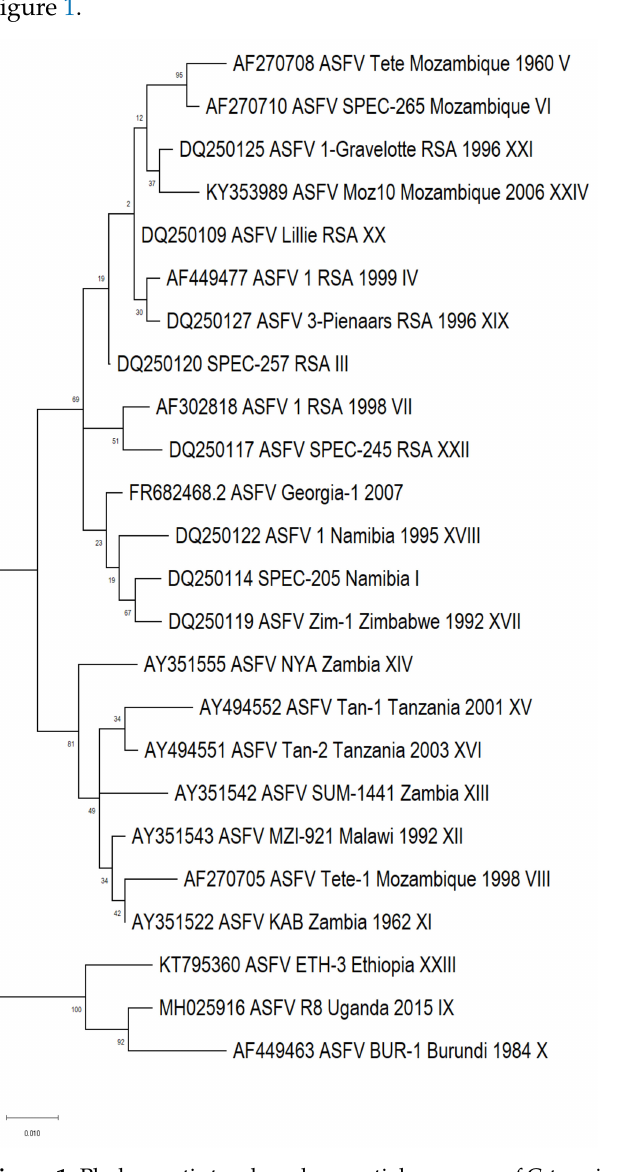
Figure 1. Phylogenetic tree based on partial sequence of C-terminal region of B646L gene, representing all 24 genotypes of ASFV, using reference isolates from